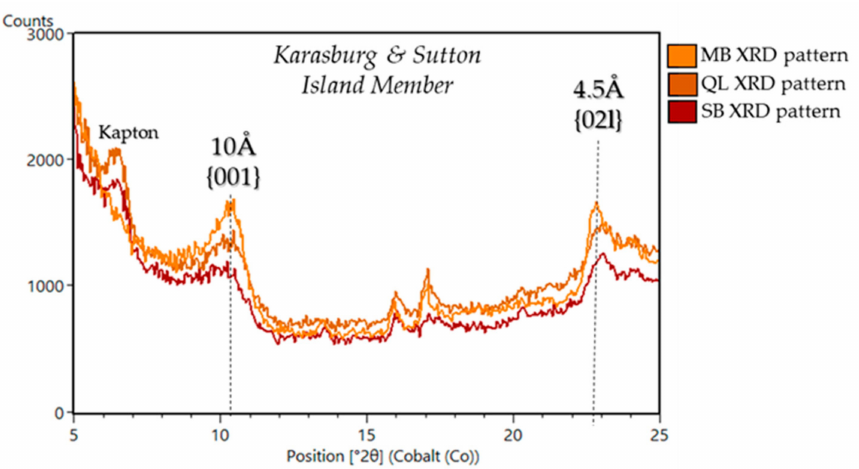
Figure 14. CheMin XRD patterns from 5 ◦ to 25 ◦ 2 θ of samples from the Karasburg and Sutton Island members. The basal d-spacing peaks of the 001 of 10 Å and 02l of 4.5 Å are denoted by dashed black lines. A pronounced 10 Å peak is seen in the MB and QL patterns, some of the highest phyllosilicate abundances are seen at this location. Kapton peak artifact is part of the sample cell and not in the rock